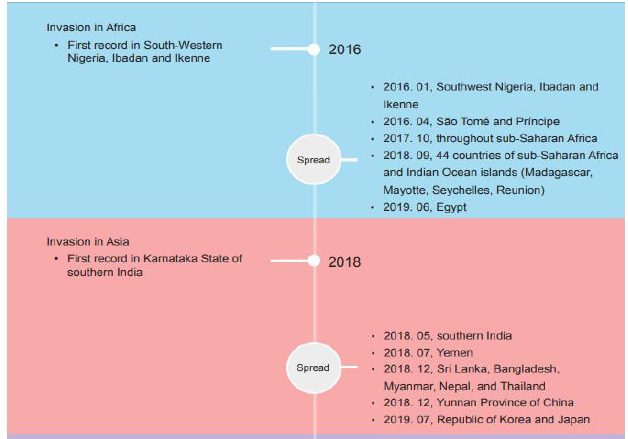
Figure 4: Adult male (left) and female (right) of FAW (Lamsal et